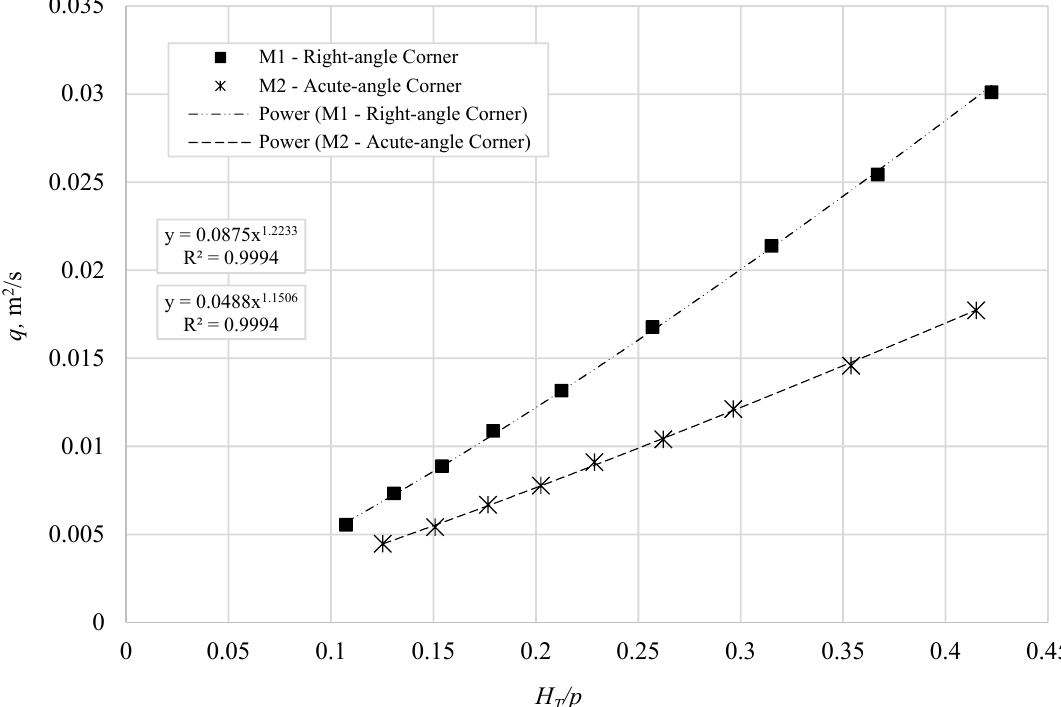
Figure 8. Comparison of discharge performance for M1 and M2 models.